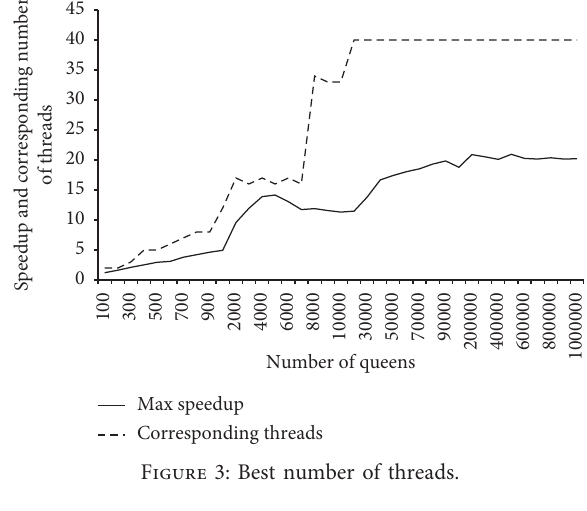
Figure 3: Best number of